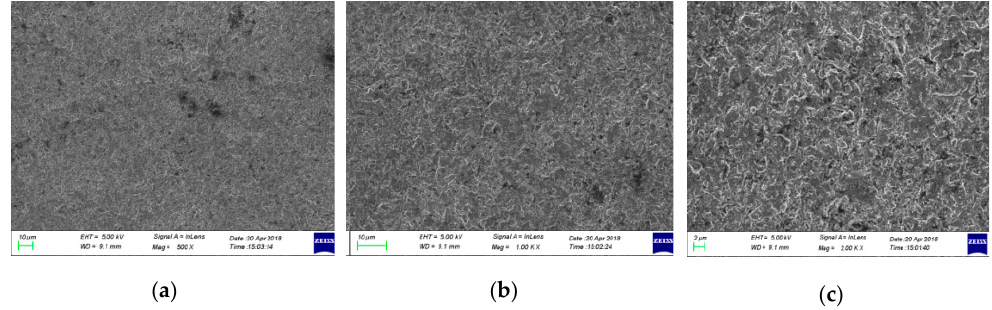
Figure 11. The surface morphology of DLC samples with the SEM: ( a ) 500 times; ( b ) 1000 times; ( c ) 2000 times.